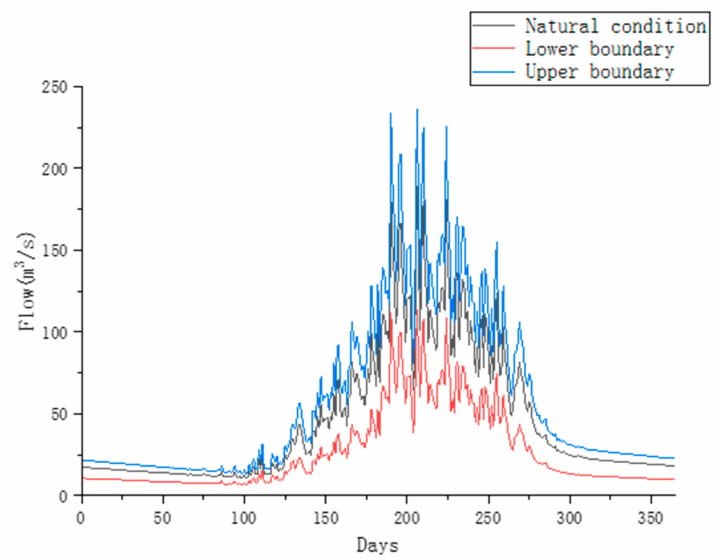
Figure 8. Optimized sustainable boundary.